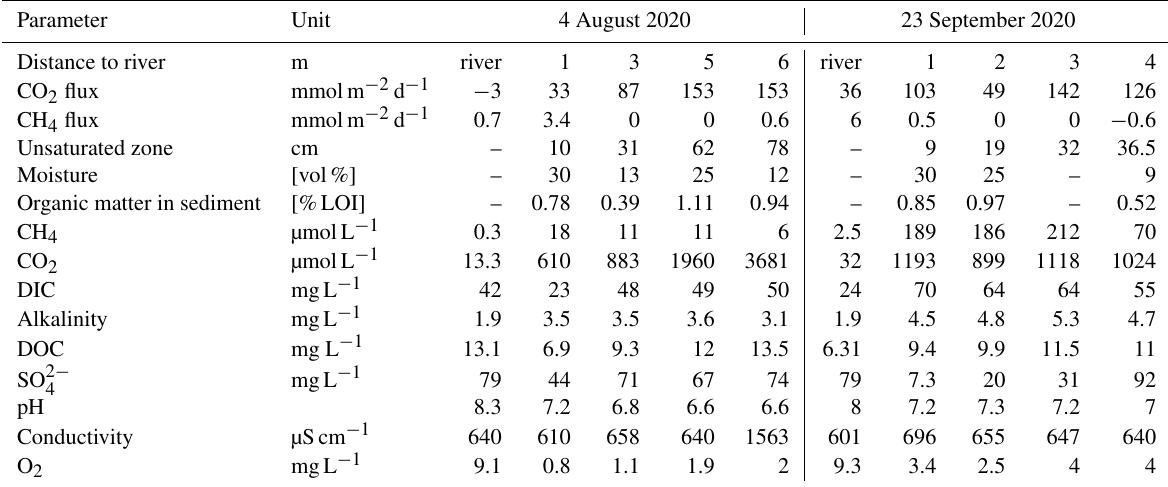
Table 1. Sediment, groundwater, and river water properties at the two sampling campaigns.